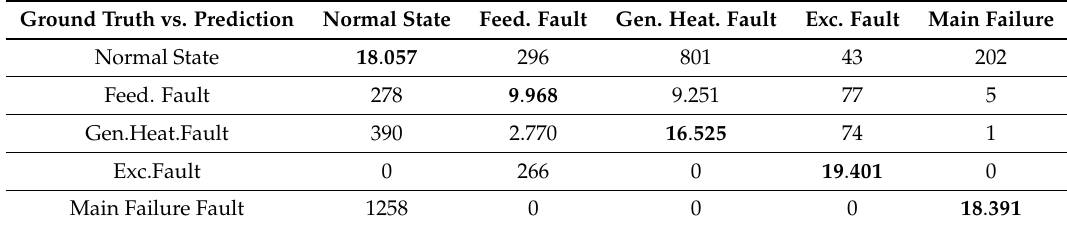
Table 5. Multiclass CNN-SAE Confusion Matrix.